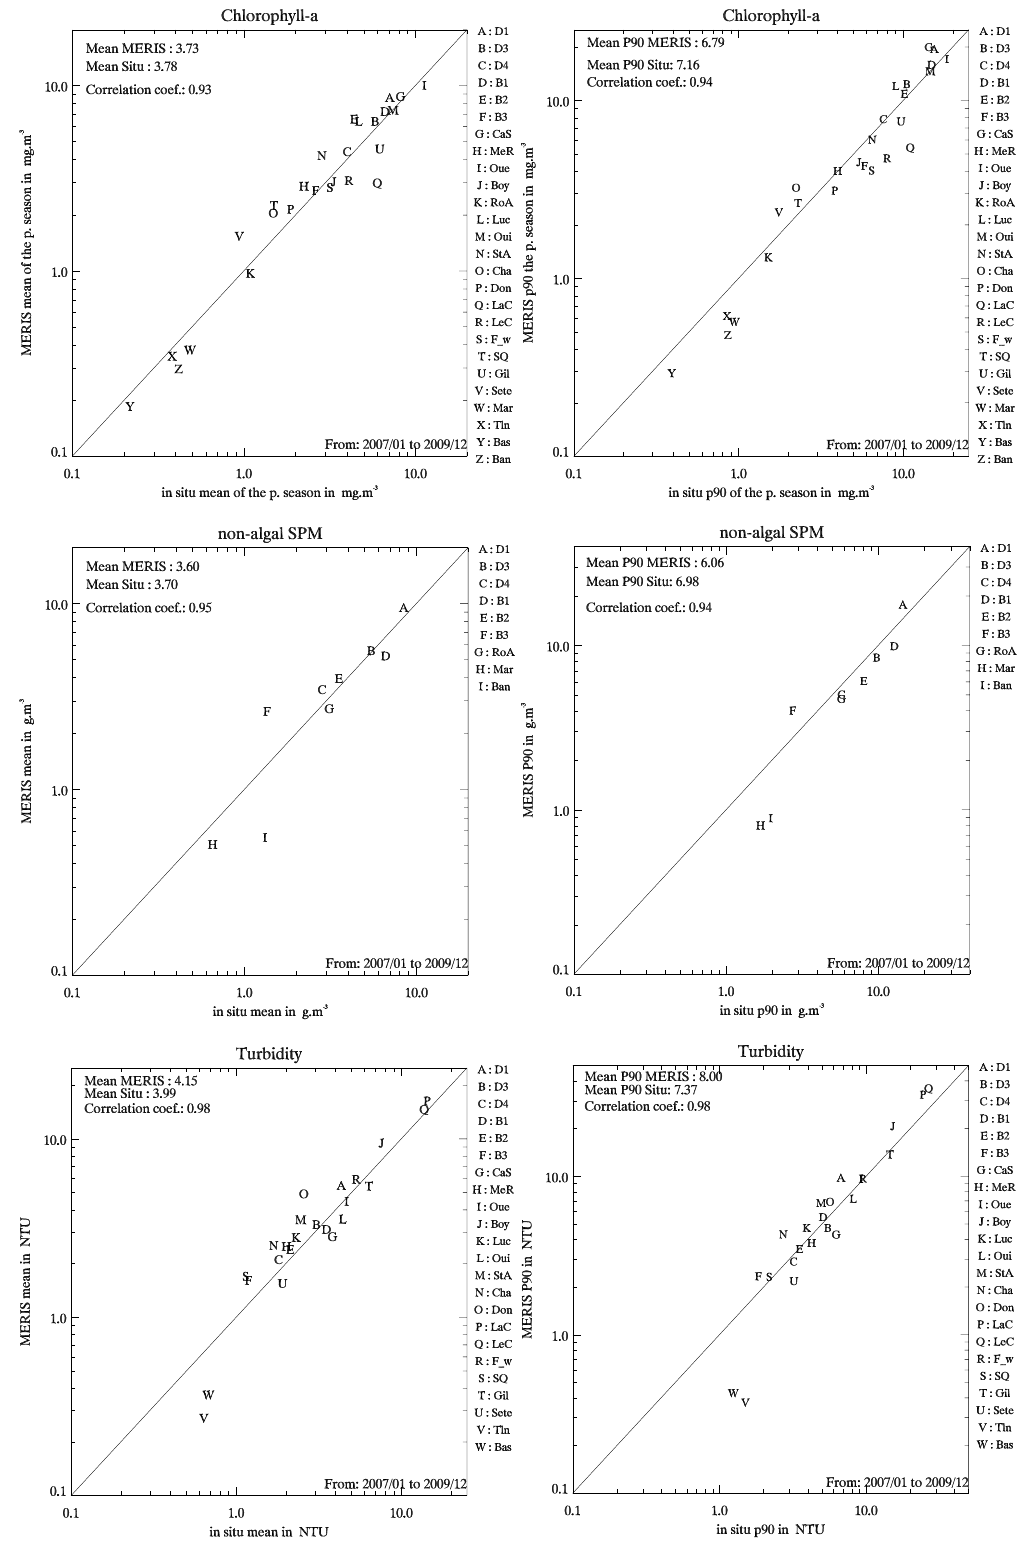
Fig. 16. Average and P90 of MERIS and in-situ Chl (productive period), non-algal SPM, and turbidity